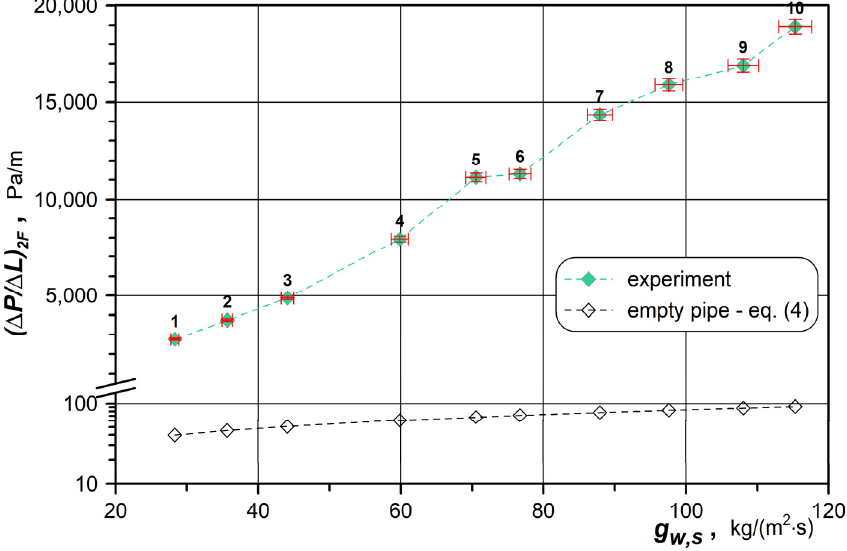
Figure 7. Measurements of specific flow resistances of two-phase flow through foams and results for empty